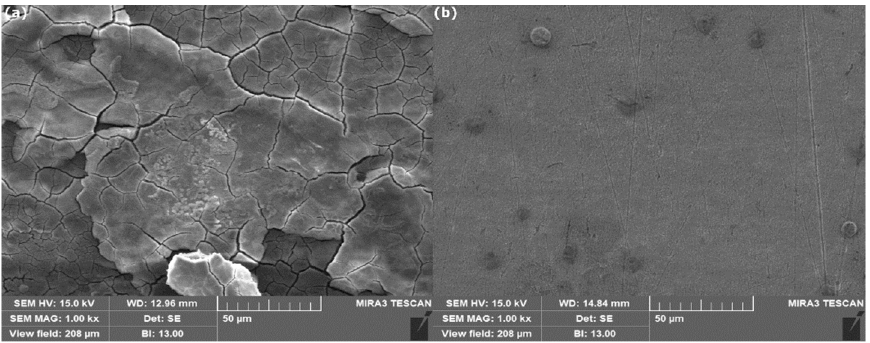
Figure 5. FE-SEM analysis of N80 steel surface in 15 wt.% HCl in the blank ( a ) and ( b ) inhibited acid solution with 5 × 10 − 3 mol/L of MAPEI.